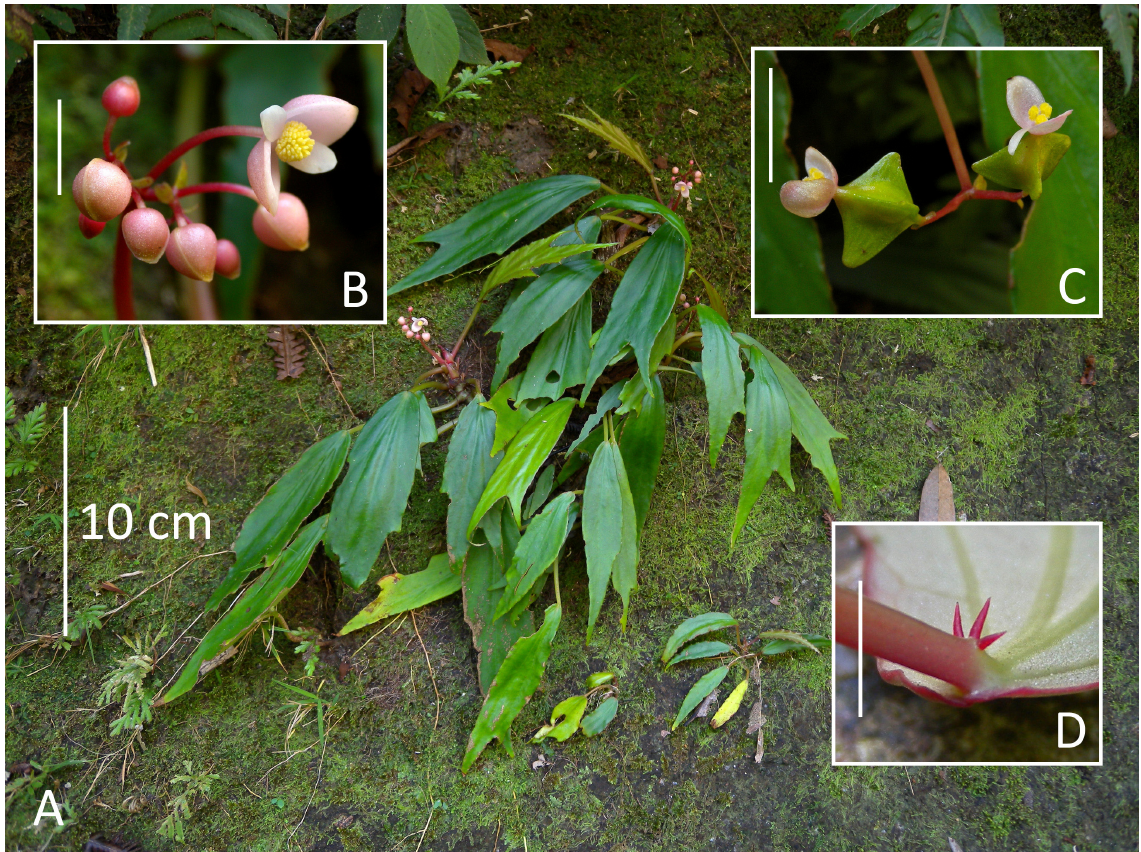
Fig. 3. Begonia fluvialis M.Hughes sp. nov. A . Habit. B . Inflorescence in male phase. C . Two female flowers. D . Petiole apex showing three red bristles. All photographs from Batang Ayer Manjuto of the type Girmansyah et al. DEDEN1489 . Scale bars on insets = 1